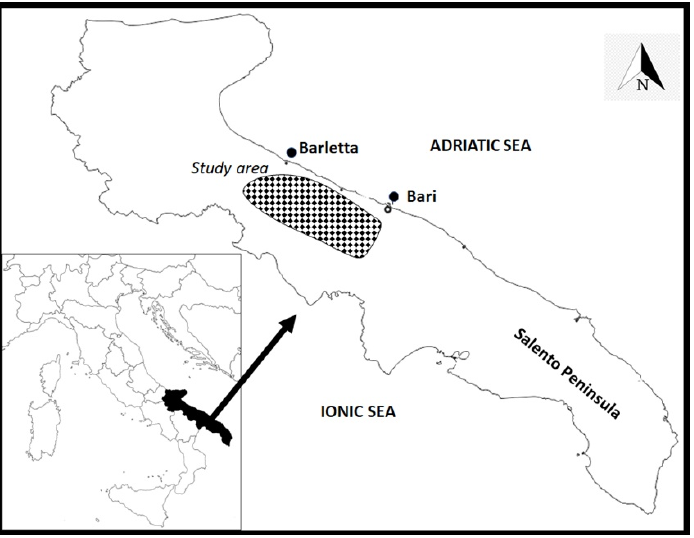
Figure 2. Map of the study area (Apulia region, South-East of Italy). The map was created from templates obtained from: https://d-maps.com/carte.php?num_car=2329&lang=it (accessed on 28 May 2020) and https://d-maps.com/carte.php?num_car=7965&lang=it (accessed on 28 May 2020).